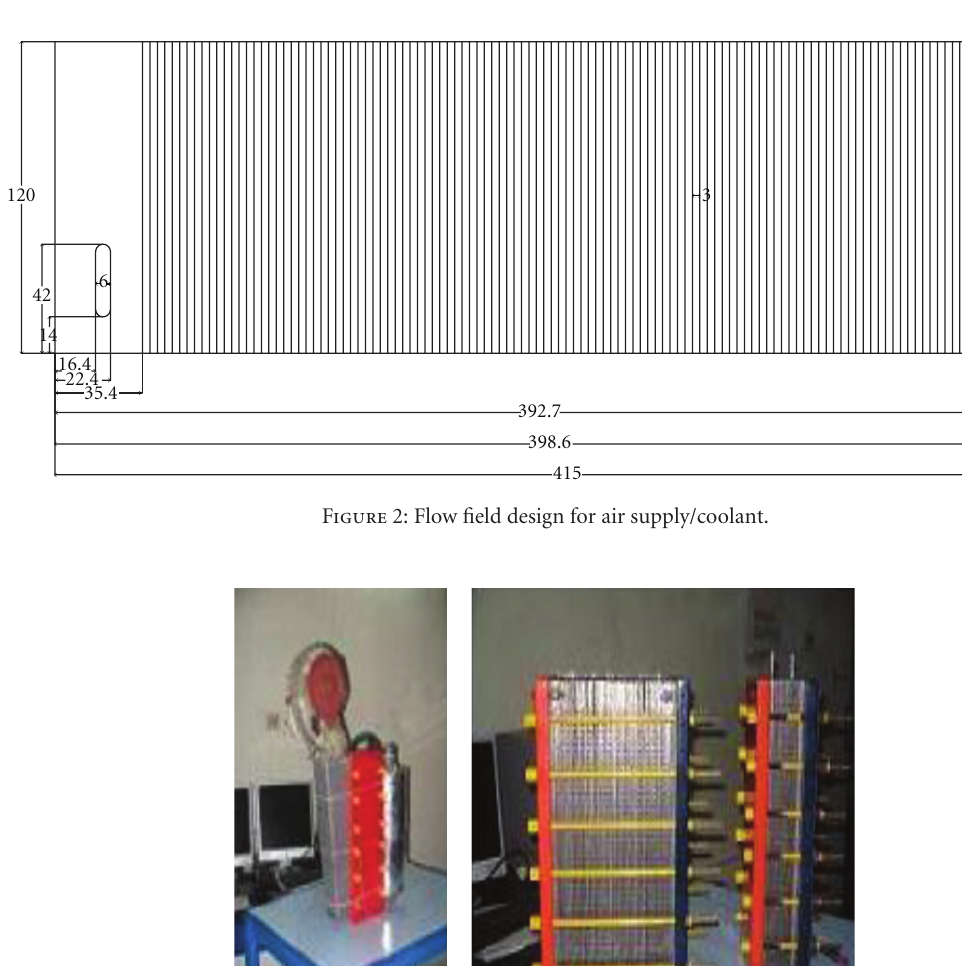
Figure 1: Schematic of stack and test apparatus.